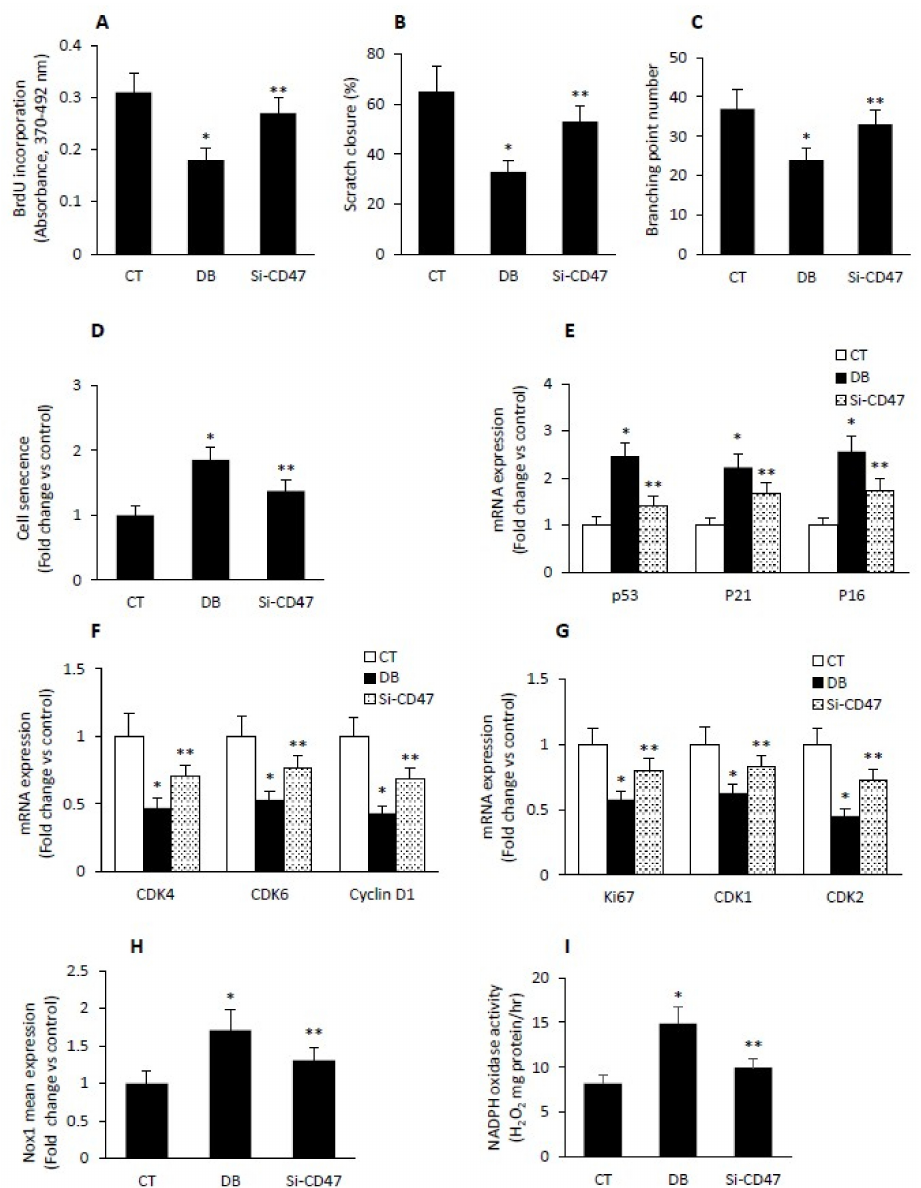
Figure 7. Diabetes impairs angiogenesis and induces endothelial cell senescence/oxidative stress by up-regulating TSP1-CD47-depndent signaling. Angiogenic capacity as reflected by cell proliferation ( A ), cell migration ( B ) and tube formation ( C ) was measured in cultured diabetic W-ECs harboring either CD47-siRNA or its corresponding scrambled siRNA. ( D ) Senescence as reflected by SA- β -gal activity was determined in in cultured W-ECs harboring either CD47-siRNA or its corresponding scrambled siRNA. Cell cycle regulators including CKIs ( E ); p53, p21, p16), cell cycle promoters ( F ); Ki67, CDK1, CDK2) and S-phase gene transcription ( G ); CDK4, CDK6, Cyclin D1) were quantified in cultured W-ECs harboring either CD47-siRNA or its corresponding scrambled siRNA using qRT-PCR-based assay. Oxidative stress, as reflected by Nox1 mRNA expression ( H ) or NADPH oxidase activity ( I ) was quantified in cultured W-ECs harboring either CD47-siRNA or its corresponding scrambled siRNA using qRT-PCR-based assay (e.g., Nox1 mRNA) or the 100,000 × g cell fraction and the fluorescence probe Amplex red (NADPH oxidase activity). Abbreviation: W-ECs, wound endothelial cells; CKIs, cell cycle inhibitors, CK, cyclin-depend kinase; CT control; DB, diabetic; Si-CD47, diabetic wound endothelial cells-treated with CD47-siRNA. Values are means ± SEM ( n = 6) * Significantly different from corresponding control values at p ≤ 0.05. ** Significantly different from corresponding diabetic control receiving scrambled siRNA at p ≤